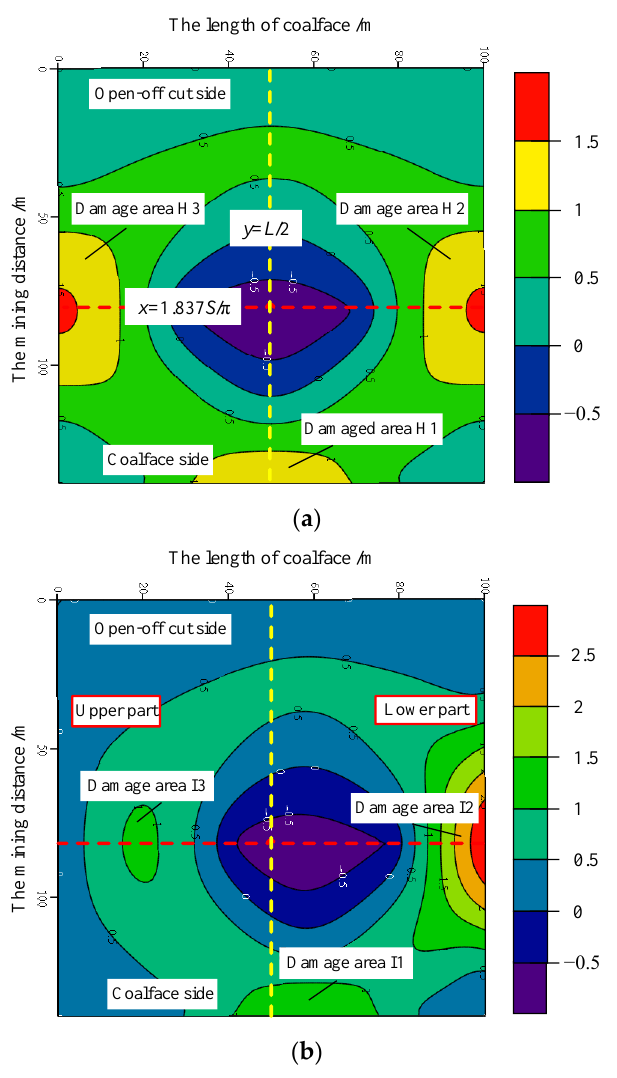
Figure 7. Water inrush zoning on the key strata (top view of the models in Figure 6b). ( a ) A case with horizontal key strata; ( b ) A case with inclined key